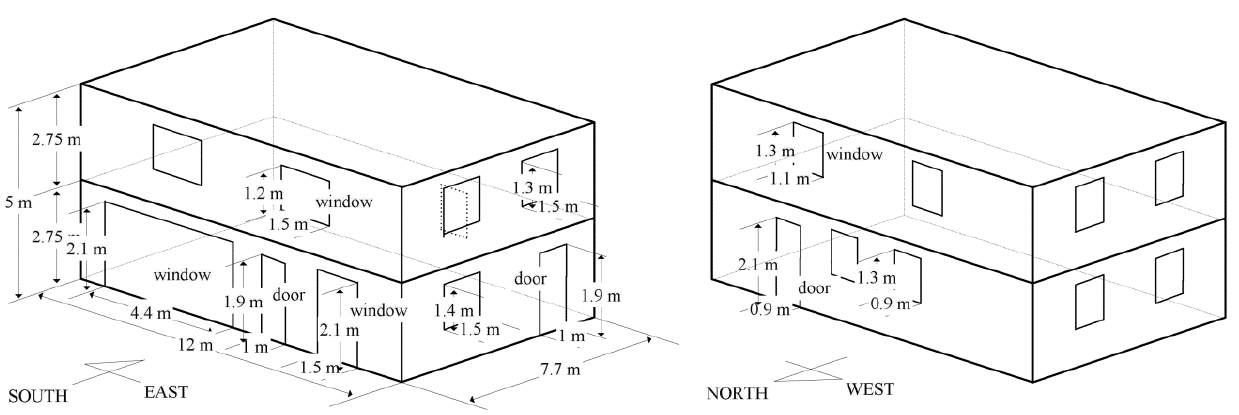
Figure 6. Views of tested building (Left: from South-East, Right: from North-West).